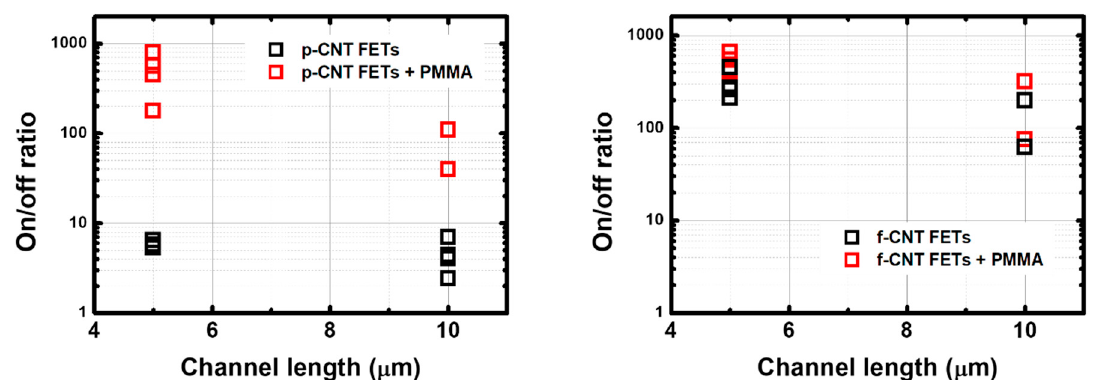
Figure 4. I on /I off ratio of ( left ) p-CNTFETs and ( right ) f-CNTFETs before and after PMMA passivation with channel length of 5 µm and 10 µm.